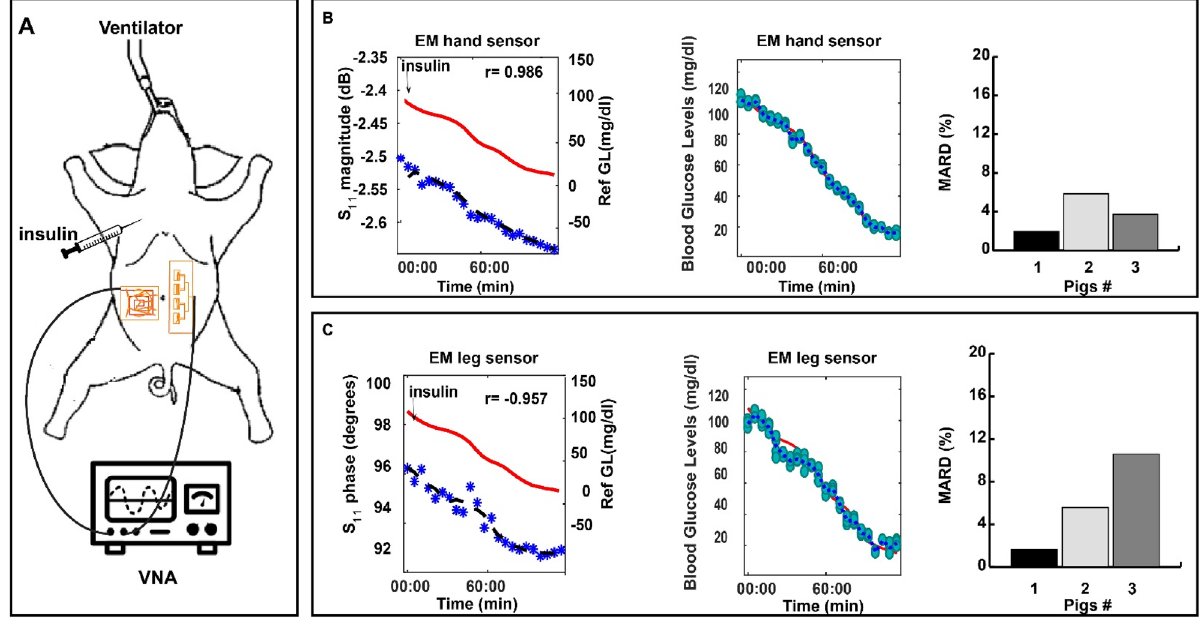
Figure 5. In-vivo experiments on pigs using the hand and the leg sensors. ( A ) Experimental setup. ( B ) EM hand sensor response during one experiment. Left, the raw antenna’s S11 parameters. Middle, predicted glucose levels. Right, MARD between the reference glucose levels and the predicted levels for the three conducted experiments. ( C ) EM leg sensor response during one experiment. Left, the raw antenna’s S1 parameters. Middle, predicted glucose levels. Right, MARD for the three conducted experiments.